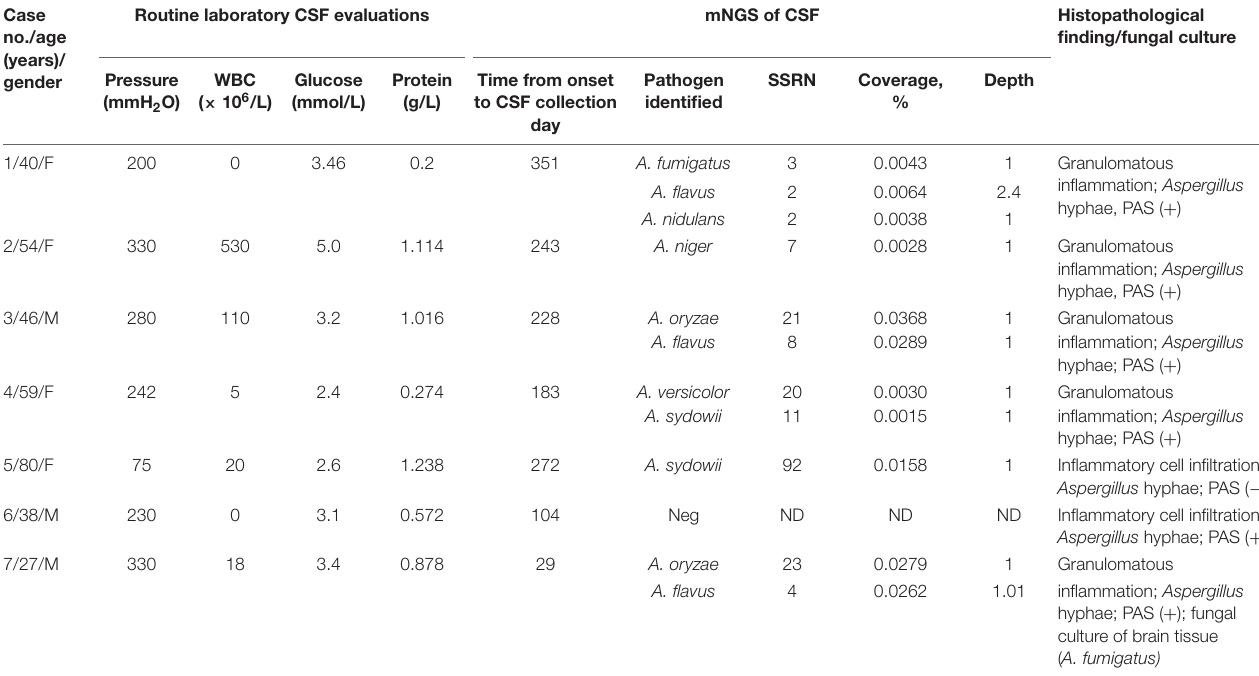
TABLE 3 | Results of CSF analysis and histopathological findings in seven patients with cerebral aspergillosis. Case